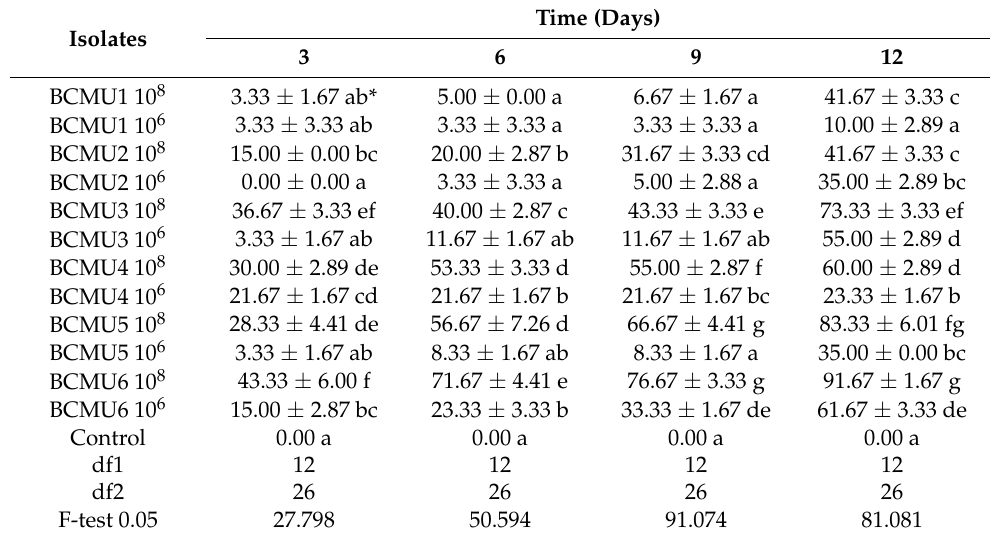
Table 3. Percentage of cumulative mortalities caused of S . frugiperda by the six isolates of B . bassiana .